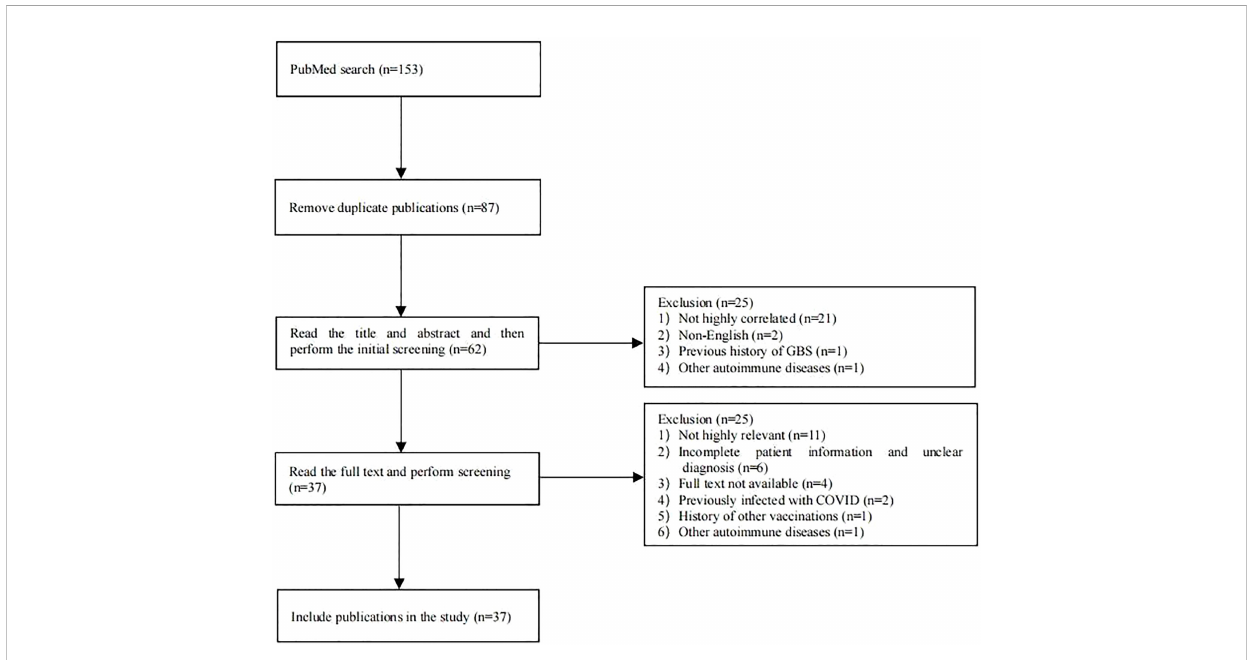
FIGURE 1 Flow chart of literature search and